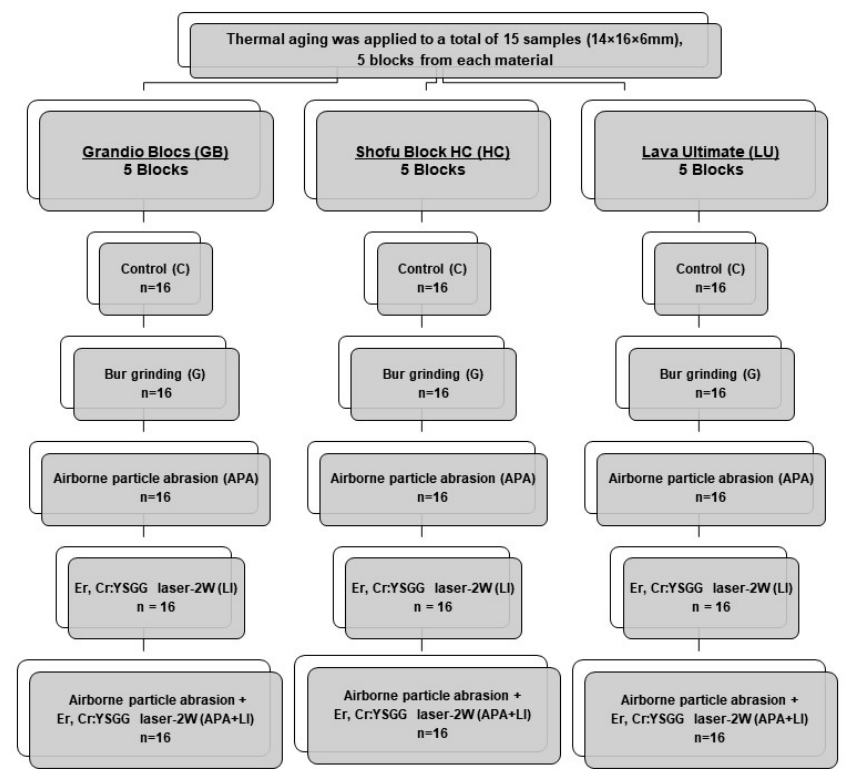
Figure 1. Schematic diagram of five surface treatments applied to each evaluated RMCs.